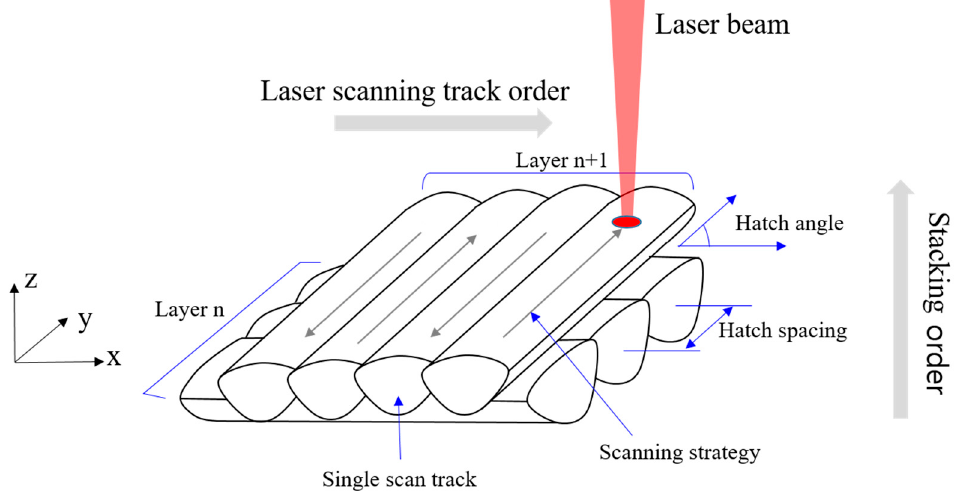
Figure 2. Concept of laser irradiation in the SLM process.